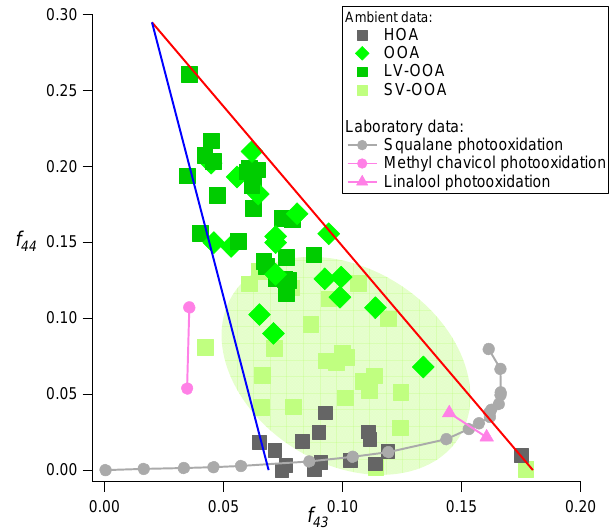
Fig. 1. Triangle plot ( f 44 vs. f 43 ) for all the OOA components from 43 ambient AMS datasets as well as selected laboratory data (adapted from Ng et al., 2010). The light green shaded area indi- cates the region where most of laboratory data fall into. It is noted that f 43 refers to ratio of total m/z 43 (C 3 H + and C 2 H 3 O + ) to to- 7 tal signal in the component spectrum for the components. The only exception to this are the squalane data (Kroll et al., 2009). The squalane data points were obtained by heterogeneous oxidation and thus f 43 contains contribution from both unreacted squalane as well as oxidized squalane products. In order to follow the production of the oxidized materials, we only show the ratio of C 2 H 3 O + to to- tal signal (i.e., f C + ) for squalane data to examine its oxidation 2 H 3 O